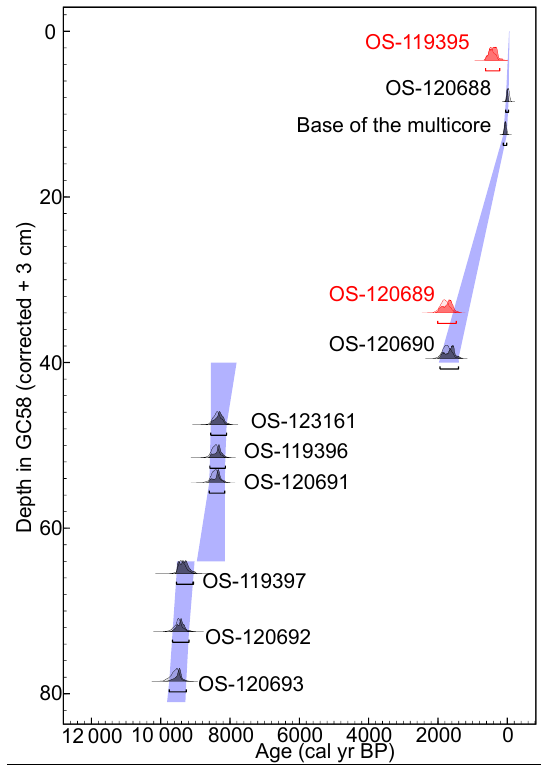
Figure 2. An age–depth model of the sediment core GC58 based on radiocarbon-dated ( 14 C) mollusc shells (see Table 1) and 210 Pb (base of a multicore collected at the same location; see Table S2 in the Supplement). All the modelled dates were calibrated with the Marine13 calibration curve (Reimer et al., 2013). A (cid:49)R value of 50 ± 100yrs was used to account for the differences in the lo- cal reservoir age based on Bauch et al. (2001a). The core GC58 dates back to ∼ 9500calyrs BP. The calibrated age probability dis- tributions are plotted for each radiocarbon date in grey. Outliers are coloured red. The blue shading indicates the modelled 2 σ probabil- ity intervals for the entire depth range of the core, and the tiny black curves indicate 2 σ for the individual